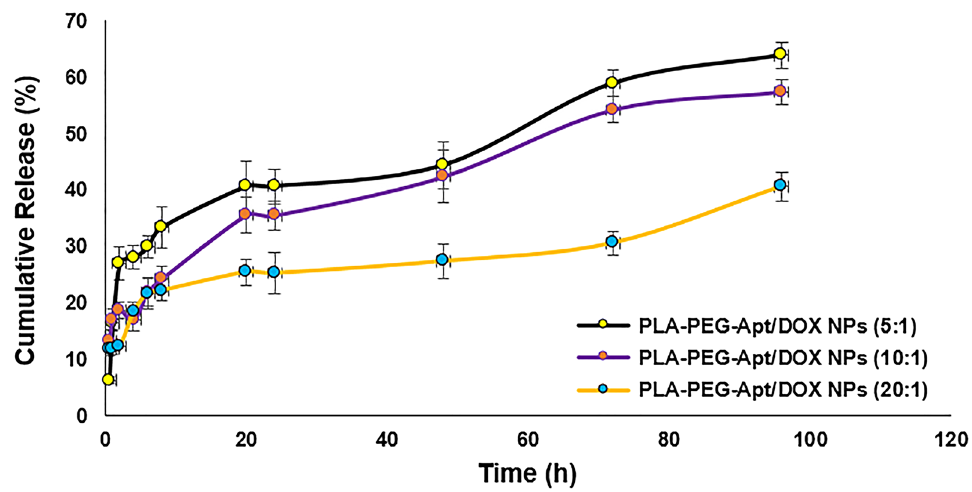
Figure 5. In-vitro release of PLA-PEG-Apt/DOX NPs at various w/w